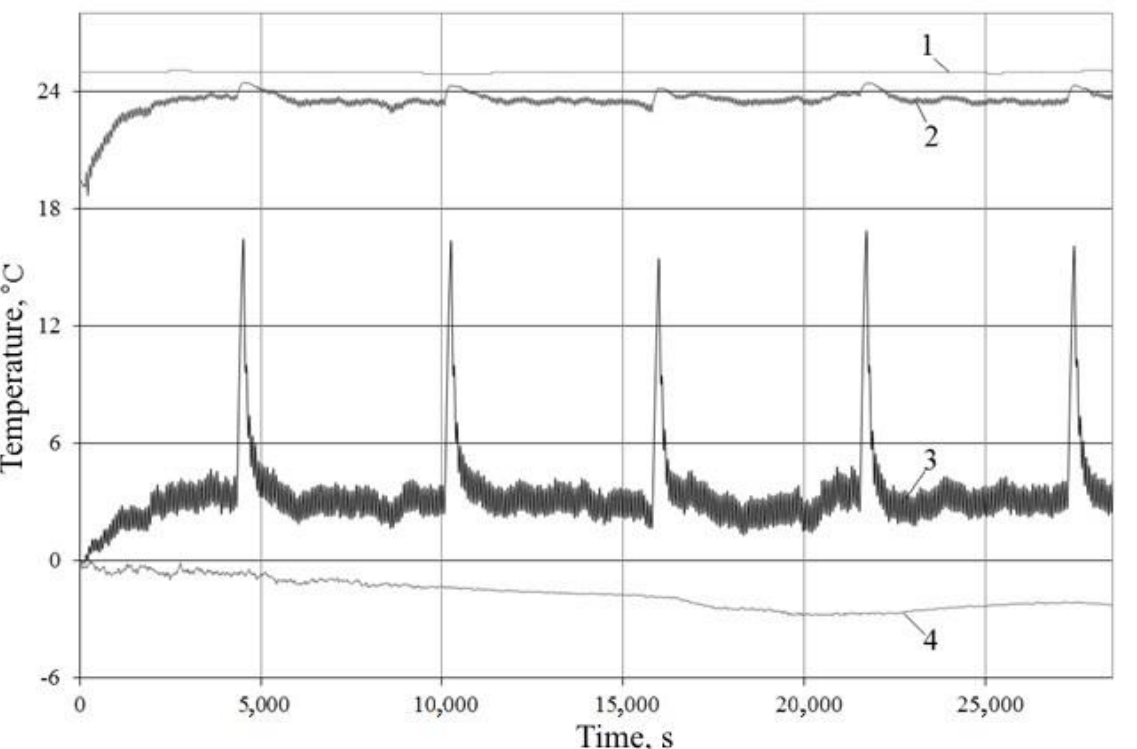
( b ) Figure 5. Cross-section (the end) of the UVRK-50 nozzle ( a ) and a scaled-up image of the cross- section of several channels ( b ). Figure 6 shows an example of the result of the air temperature measurements at the experimental installation. The experiment was carried out at the outdoor air temperature T out = 0–−2.8 °C, the indoor air temperature T in = 24.9–25.1 °C, and the air flow through the